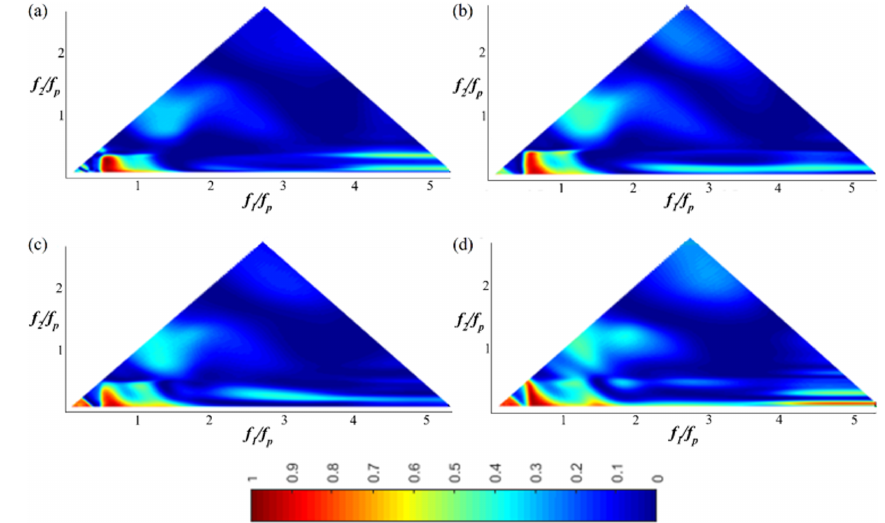
Figure 9. The wavelet-based bicoherence spatial evolution on the flat bottom for the JONSWAP ( γ = 7) wave train (Test 7). (a) x = 4m; (b) x = 6 . 4m; (c) x = 8m; (d) x = 9 . 6m.